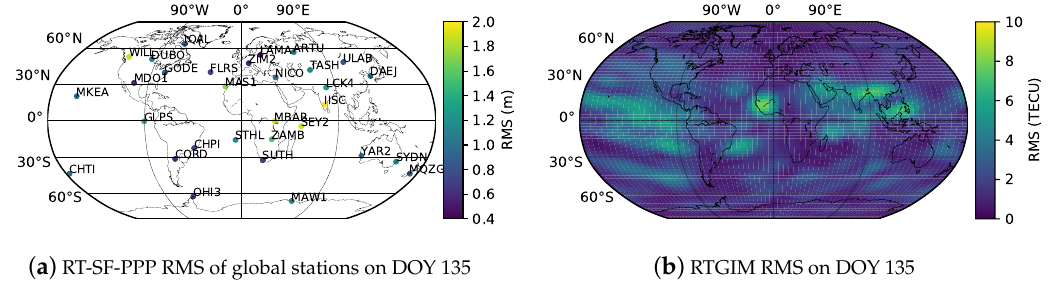
Figure 15. Global maps of RT-SF-PPP and RTGIM